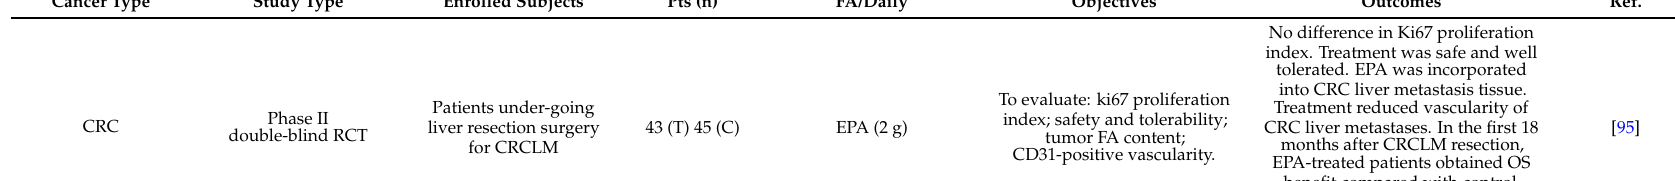
Table 1. Overview of human studies investigating the clinical outcome or prognosis in cancer patients supplemented with n- 3 polyunsaturated fatty acids (PUFAs). Cancer